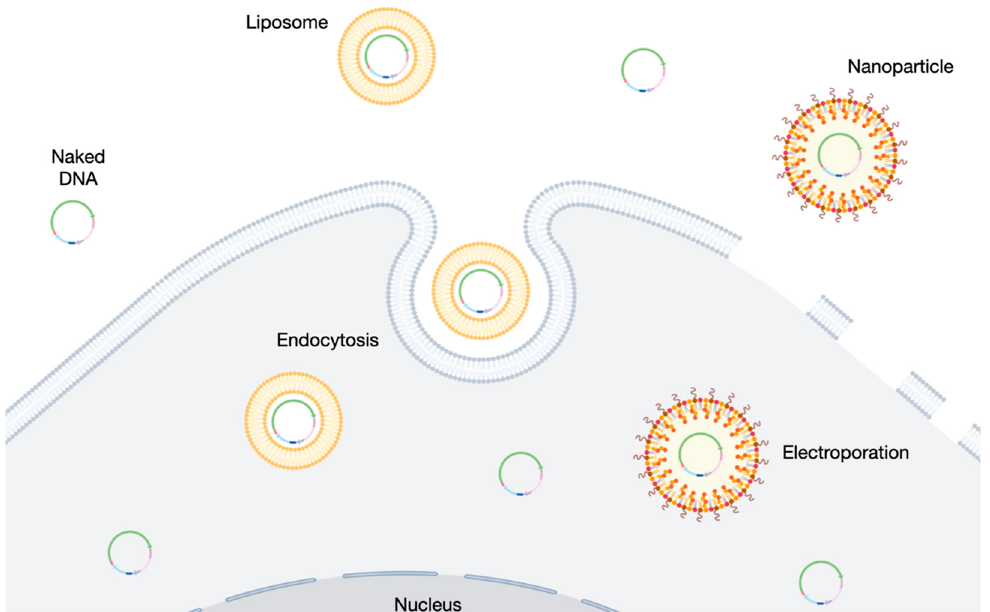
Figure 2. Overview of common delivery modes for minicircle entry into the target cell, including naked DNA delivery, liposome-based transfection, and